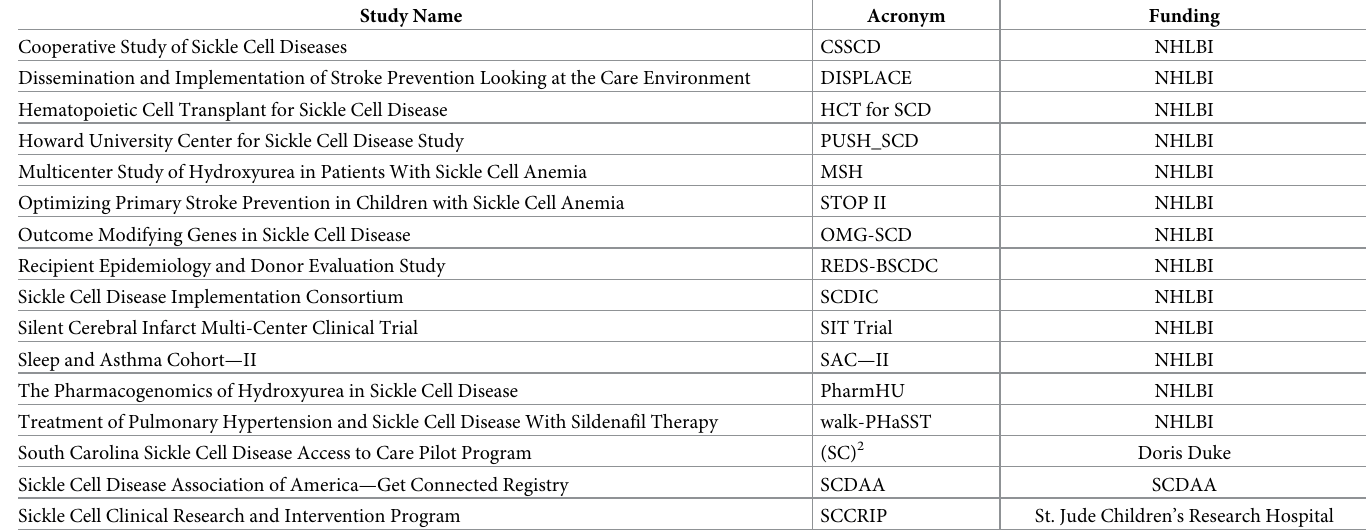
Table 1. List of SCD studies released in CureSCi